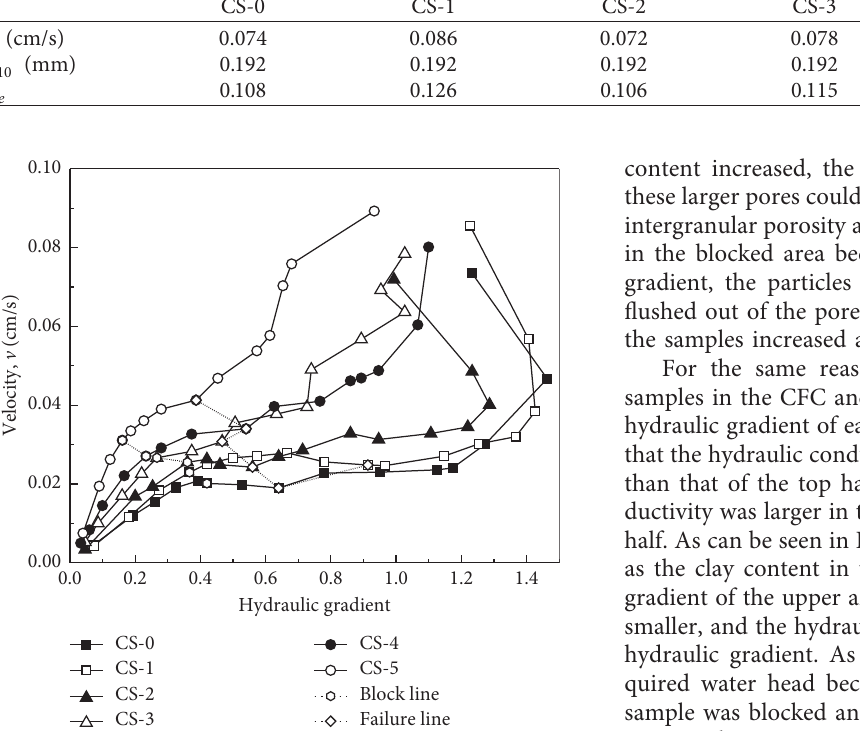
Figure 11: Variation of flow velocity with hydraulic gradient for the CS